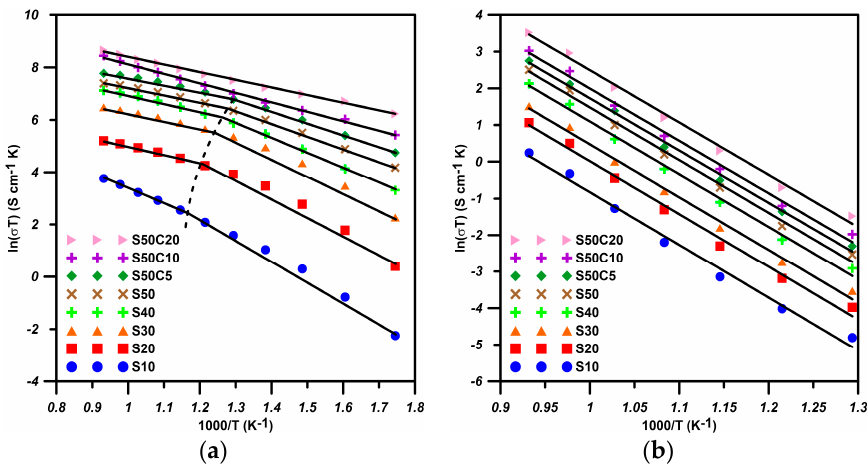
Figure 2. Arrhenius plot of: ( a ) electrical conductivity; and ( b ) ionic conductivity of S x C y bismuth ferrites with different Sr- and Co-doping. Table 2. Activation energy of electrical conductivity calculated from Arrhenius plots of electrical